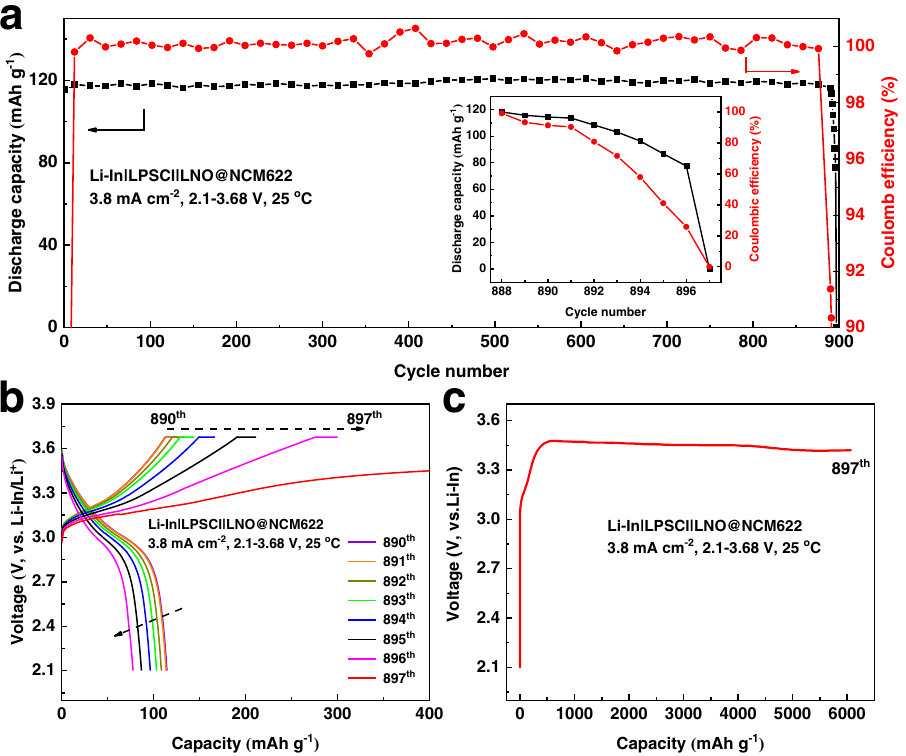
Fig. 1 Cycling performance of the Li-In|LPSCl|LNO@NCM622 cell. a Long-term cycling performance at 3.8 mA cm − 2 at 25 °C. The inset shows the variation of discharge capacity and columbic ef fi ciency from the 888th to 897th cycle. b Galvanostatic charge-discharge pro fi les from the 890th to 897th cycle. c Galvanostatic charge pro fi le for the 897th